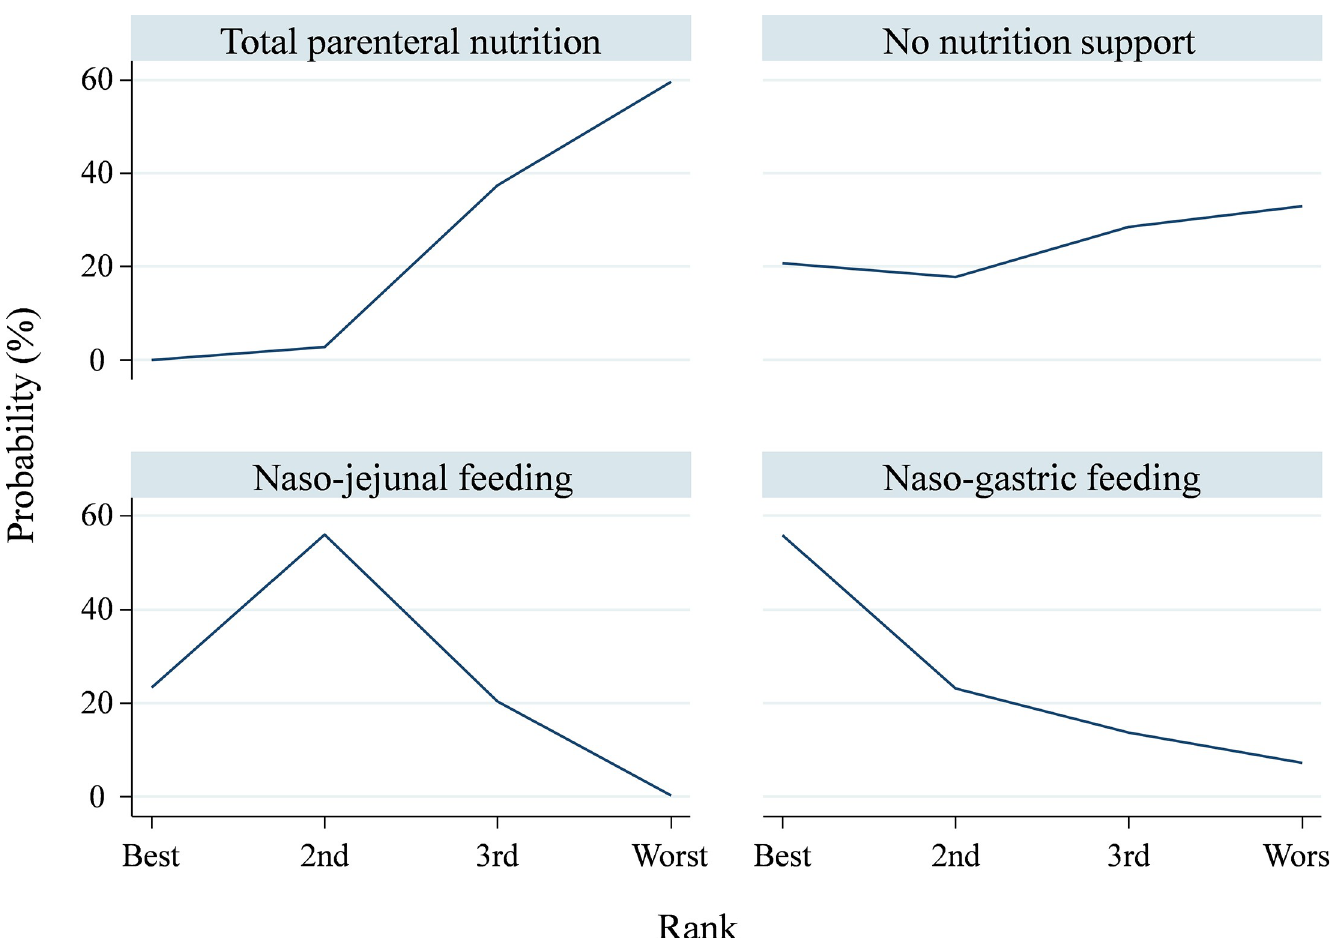
Fig 3. Surface under the cumulative ranking curve of total number of infectious patients among nutritional therapies and no nutritional